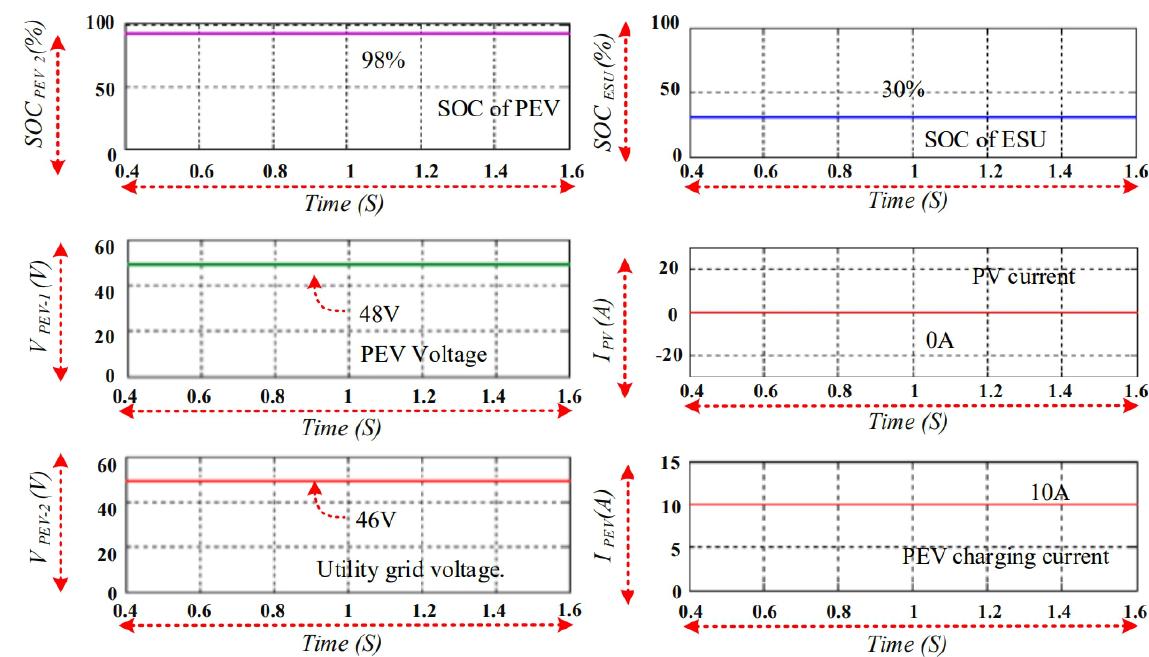
Fig. 7. (a) PEV-2 to PEV-1 charging mode, (b) Utility grid to PEV